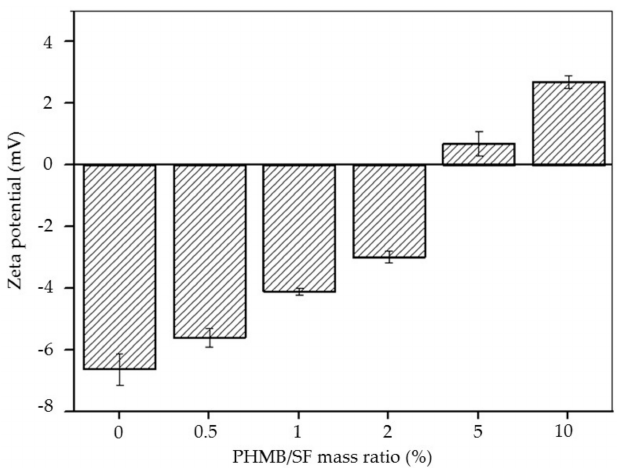
Figure 2. Zeta potential of poly(hexamethylene biguanide) hydrochloride (PHMB) / silk fibroin (SF) complexes at di ff erent w / w ratios.